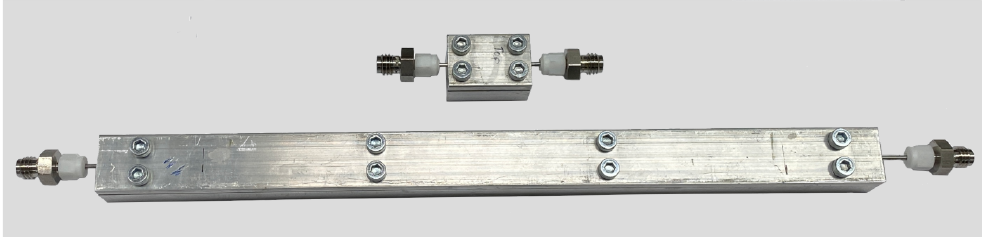
Figure 12. Capillary tubes of length 300mm and 50mm with matching holders used for viscosity measurements at